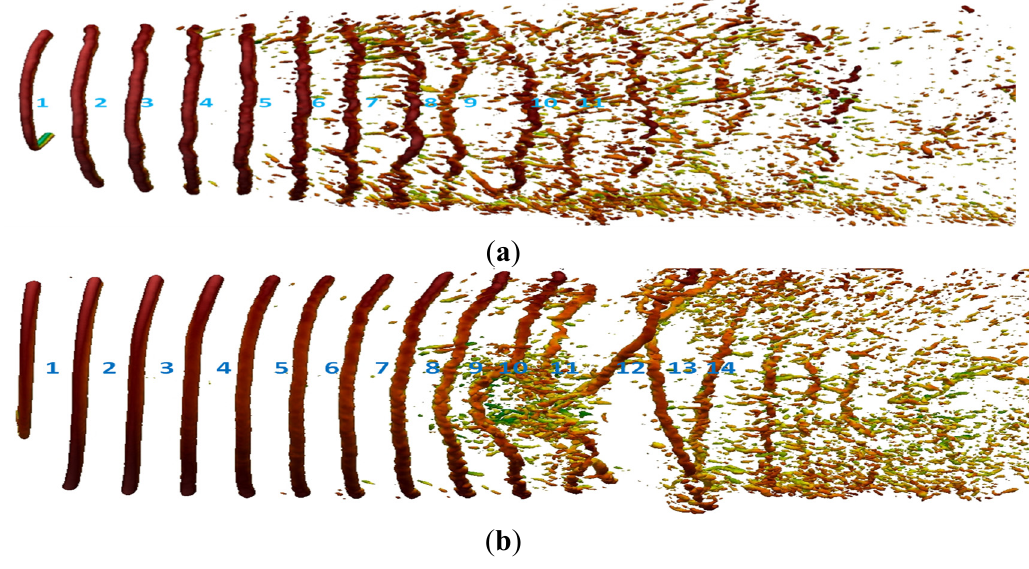
Figure 13. Top view of iso-contours of the vortex field that has been isolated near the tip vortex for the WT in ( a ) low-stable; ( b ) moderate -stable ABL regime. Iso-contour levels corresponding to (0.5–2.0 1/s) have been